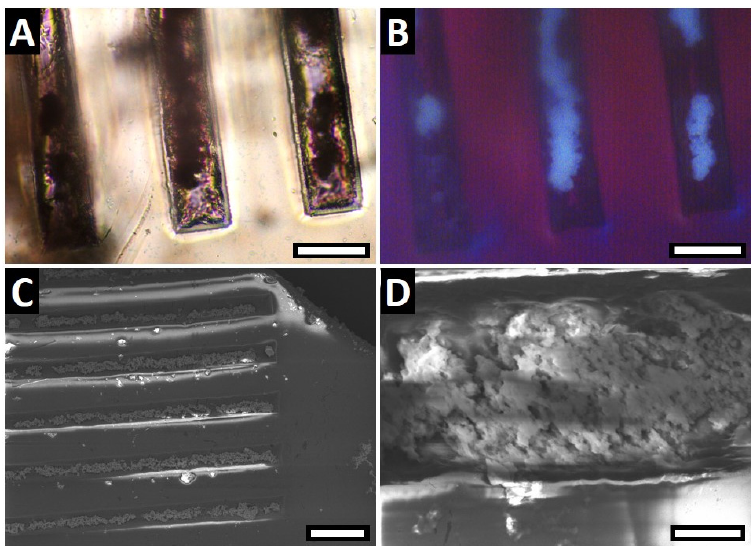
Figure 3. ( A ) LM image of an HApP-infiltrated MCTS, after an incubation time of seven days in the remineralization solution showing CaP-filled channels (dark area, scale 50 µm); ( B ) PLM image of ( A ) shows the crystallinity of the CaP-filling material (blue) in the channels (scale 50 µm); ( C ) SEM overview image of several CaP-filled MCTS channels (scale 100 µm); and ( D ) SEM image shows the partially fused CaP particles in one channel (scale 10 µm).